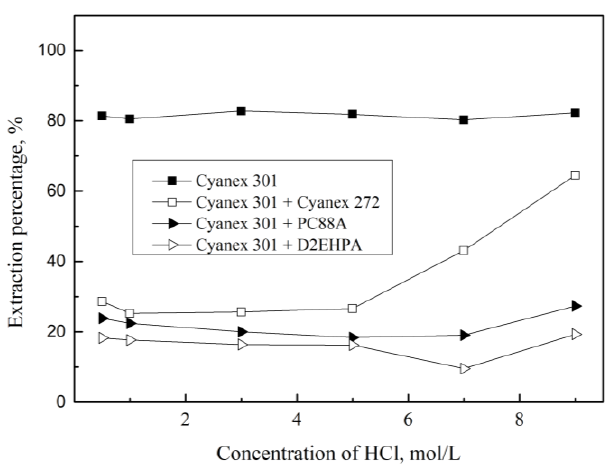
Figure 1. Effect of HCl concentration on extraction of Pd(II). Aqueous: [Pd] = 100 mg/L, [HCl] = 0.5–9 mol/L. Organic: 0.01 mol/L Cyanex 301, 0.01 mol/L Cyanex 301 + 0.1 mol/L Cyanex 272/PC 88A/D2EHPA. Organic per aqueous phase ratio (O/A) = 1. Diluent: kerosene.